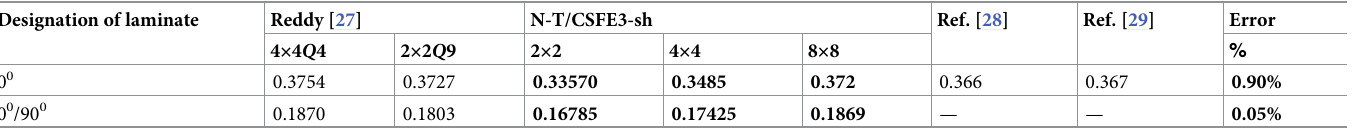
Table 1. Maximum radial deflection ( W 0 in .) of the cylindrical laminate shell with embedded-ends under internal pressure. Designation of